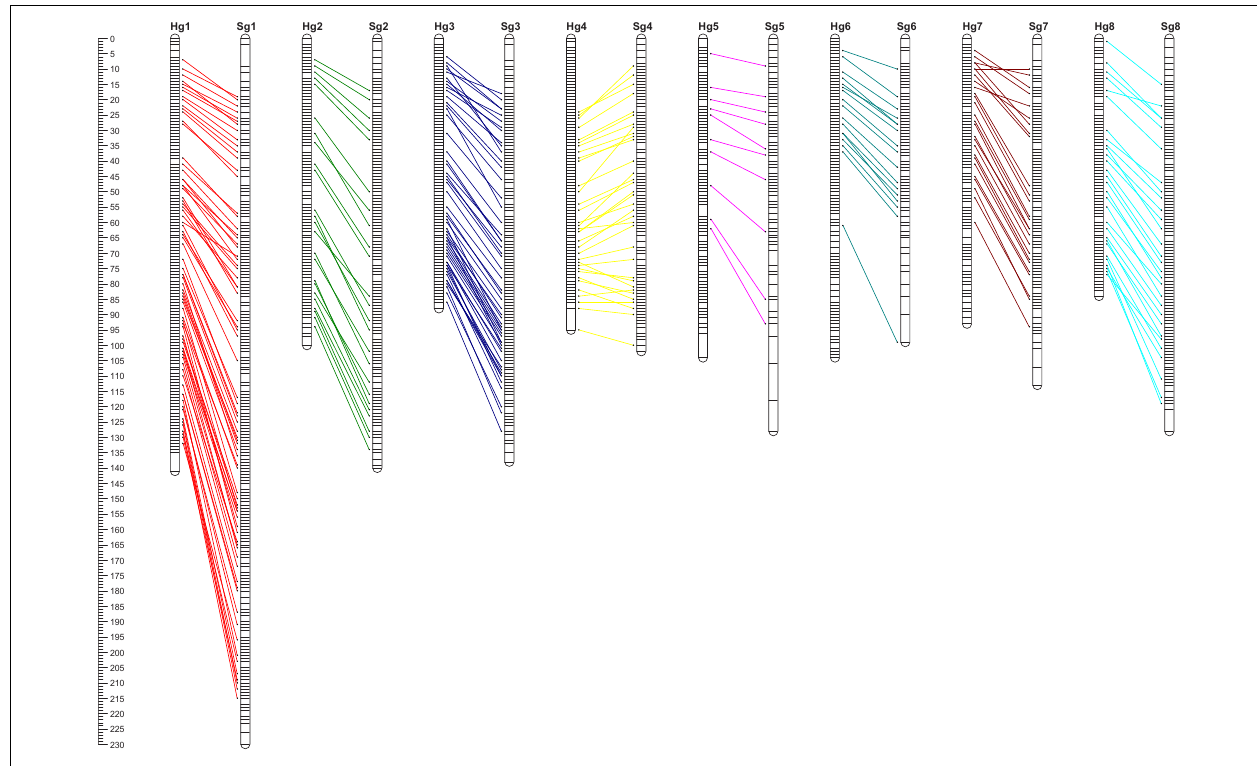
FIGURE 2 | Comparison of genetic map between “Chuanzhihong” (H) and “Saimaiti” (S).